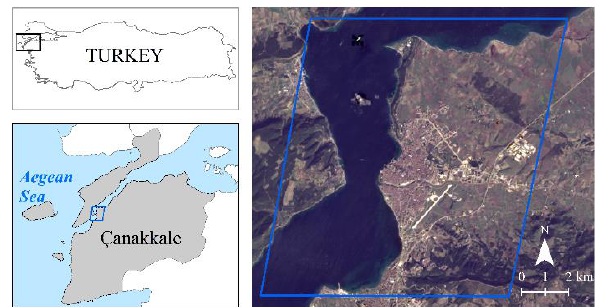
Figure 1. Upper left image belongs the map of Turkey, lower left image belongs to the map of Çanakkale Province, right image belongs to the Landsat-9 image true color composite, which was acquired on 18.01.2022, of the geographical location of the study area.